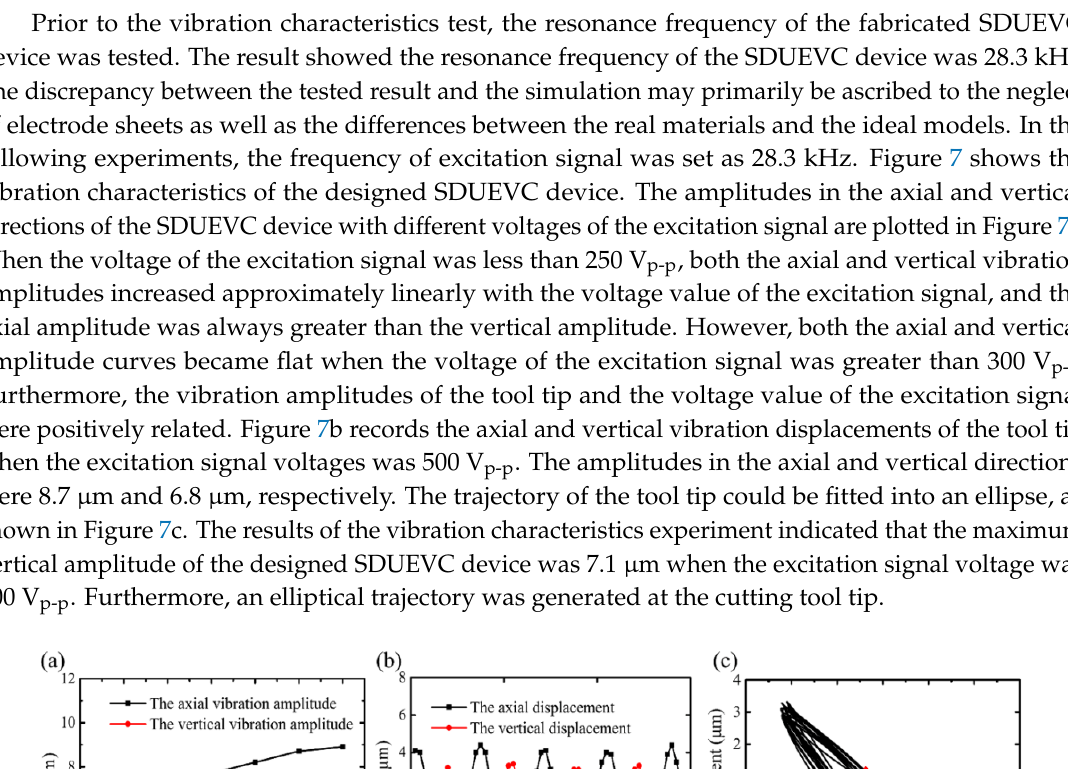
Figure 6. Designed SDUEVC device and the vibration characteristics testing instruments.